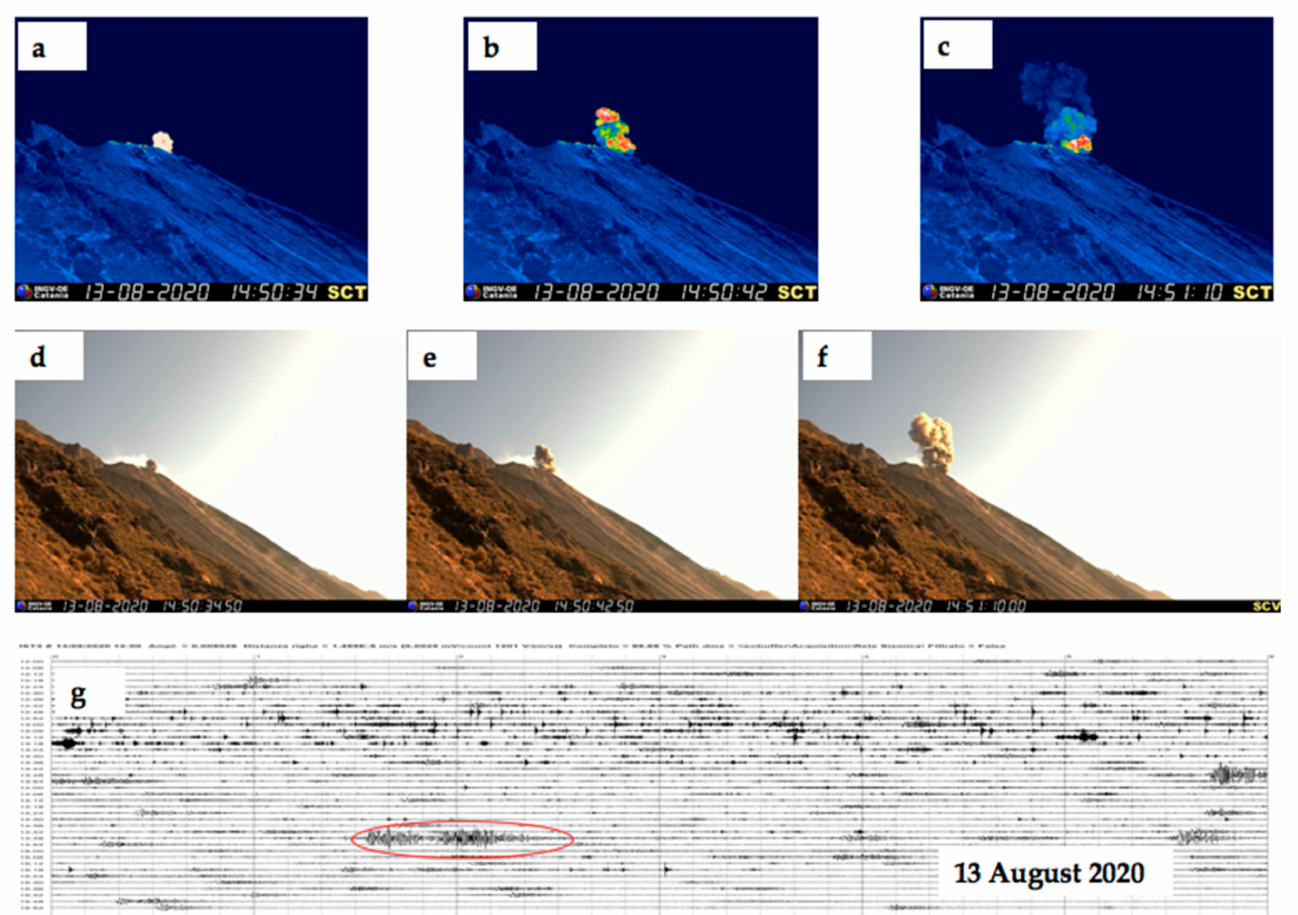
Figure 10. ( a – c ) Thermal images recorded from the SCT camera on 13 August 2020 at 14:50:34 ( a ), at 14:50:42 ( b ), and at 14:51:10 ( c ). Blue is cold, white is hot. View from NE. ( d – f ) Corresponding visual images from the SCV camera, view from NE, recorded at 14:50:3450 ( d ), at 14:50:4250 ( e ), and at 14:51:1000 ( f ). ( g ) Seismic trace of the explosive event as recorded from the IST3 seismic station, Z component. The red oval indicates the seismic trace corresponding to the event shown above. See Figure 1 for station